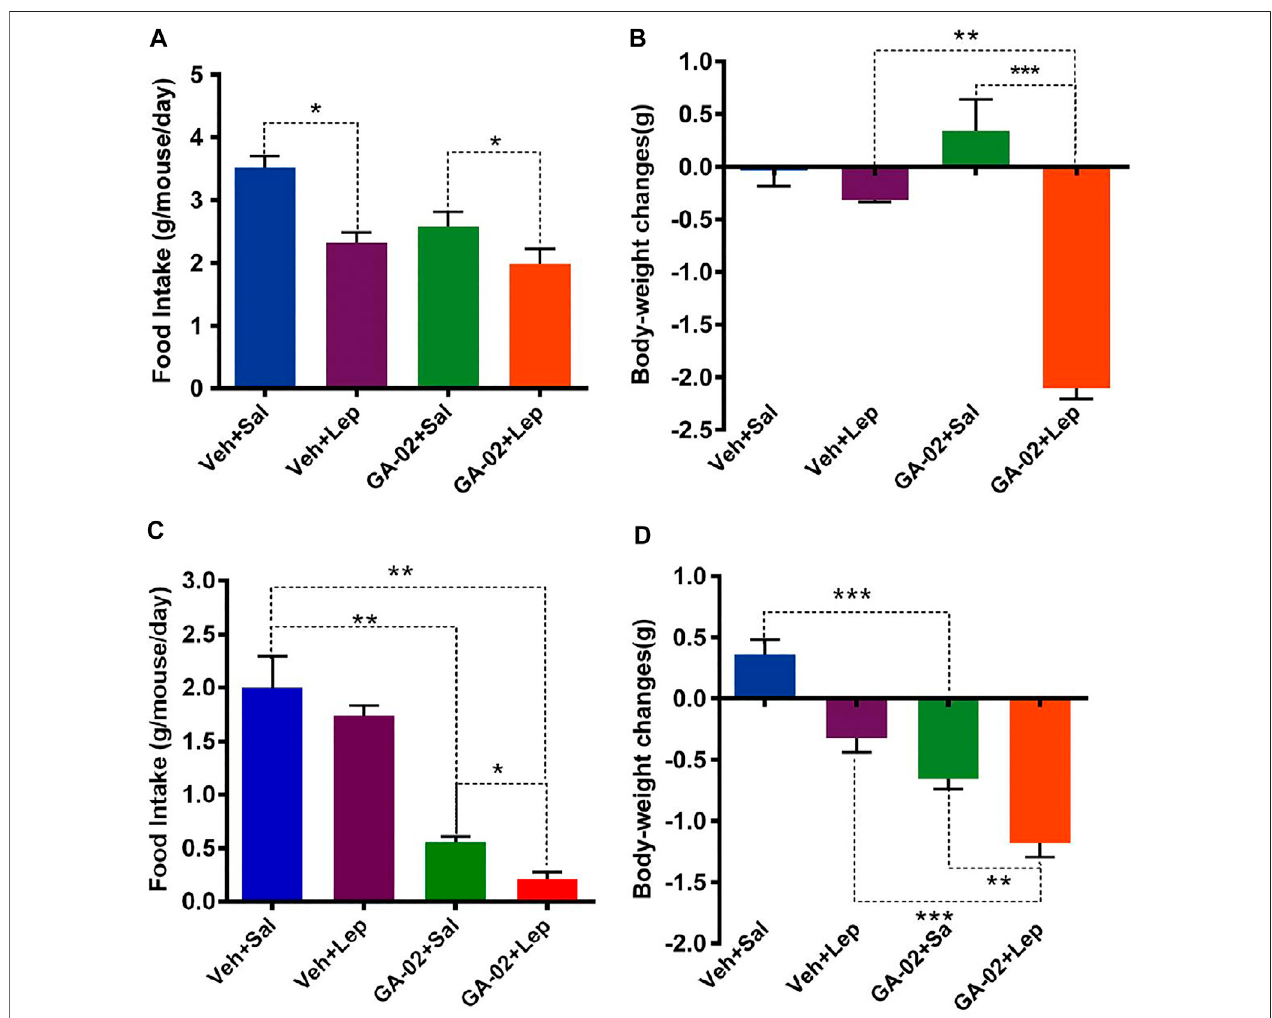
FIGURE 7 | GA-02 activates leptin signaling in the hypothalamus of DIO mice. Representative images (A) and quantitative cell number (B) of pSTAT3 (Tyr705)- positive cells from the ventromedial hypothalamus (VMH); Mice with DIO received vehicle or GA-02 (20 mg/kg, 15 h; i.p.) and then were injected with saline or leptin (1 mg/kg, 30 min; i.p.). (C) NE concentration in epididymal and subcutaneous fat of DIO mice that were injected with vehicle or GA-02 (20 mg/kg) for 3 days and subsequentlygivensalineorleptin(1 mg/kg).Representativeimagesofimmunostaining (D) andrelative fl uorescenceintensity (E) ofp-HSL(red)inparaf fi nsections ofepididymalfatofDIOmicethatwereadministeredvehicleorGA-02(20 mg/kg)for3 daysandsubsequentlygivensalineorleptin(1 mg/kg).Scalebar,100 µm.Values are represented as mean ± SD. (* p < 0.05, ** p < 0.01, *** p < 0.001).